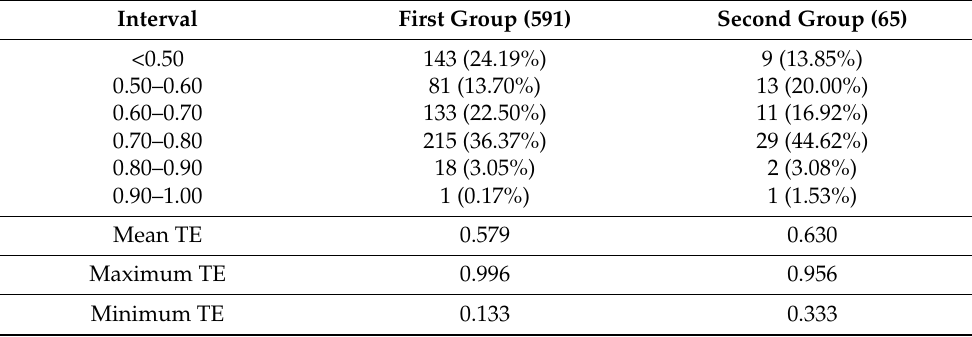
Table 5. Percentages of technical efficiencies based on the Gaussian family copula of major rice farmers within decile